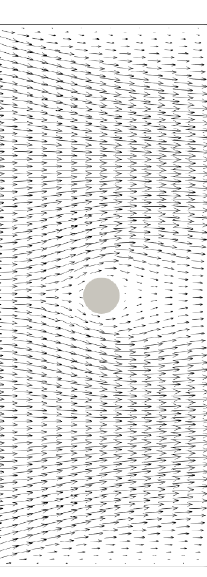
Figure 11. Velocity vector with Uinlet = 0.2 and Re = 180. Table 1. Simulation and analytical drag coefficient of different Reynolds number.